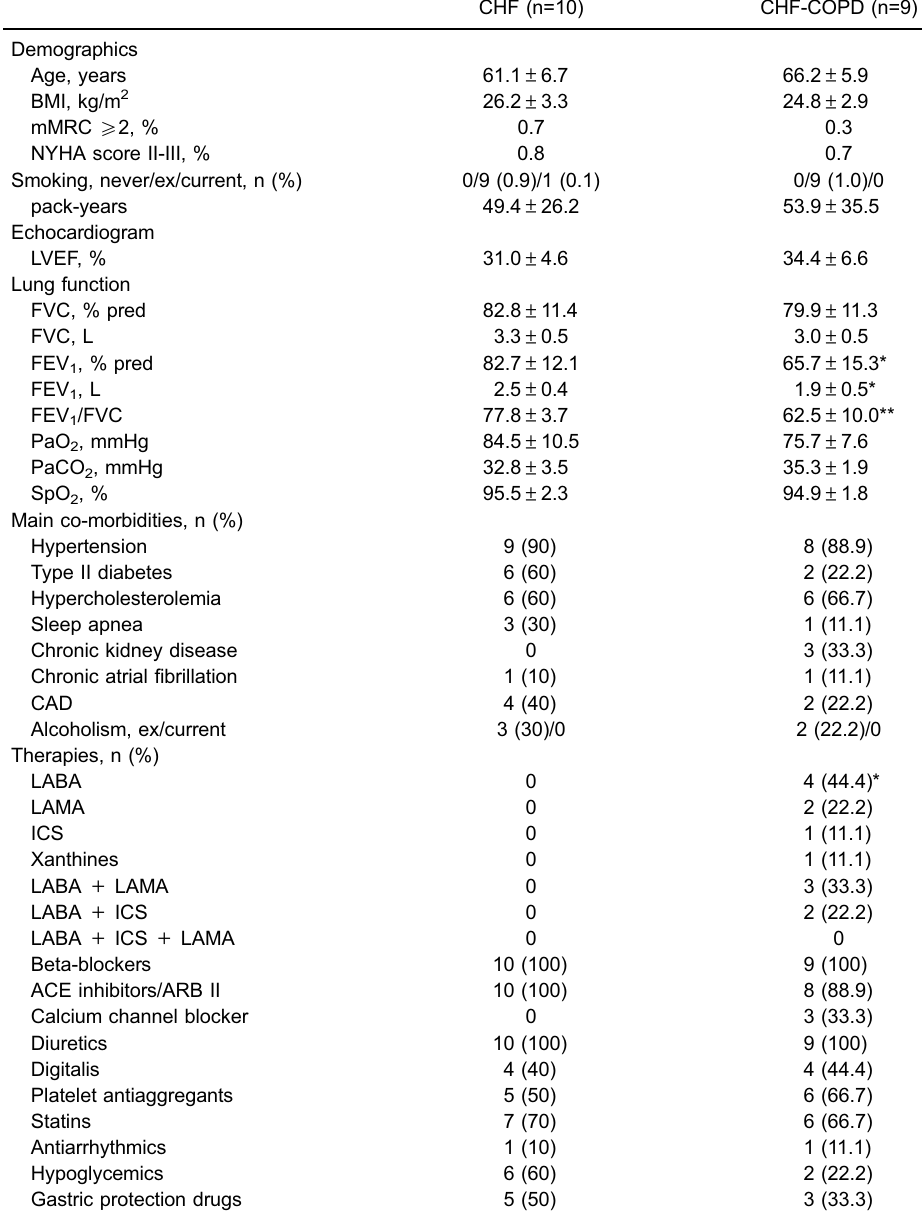
Table 1. Baseline demographic and clinical characteristics data of patients with chronic heart failure (CHF) and CHF-chronic obstructive pulmonary disease